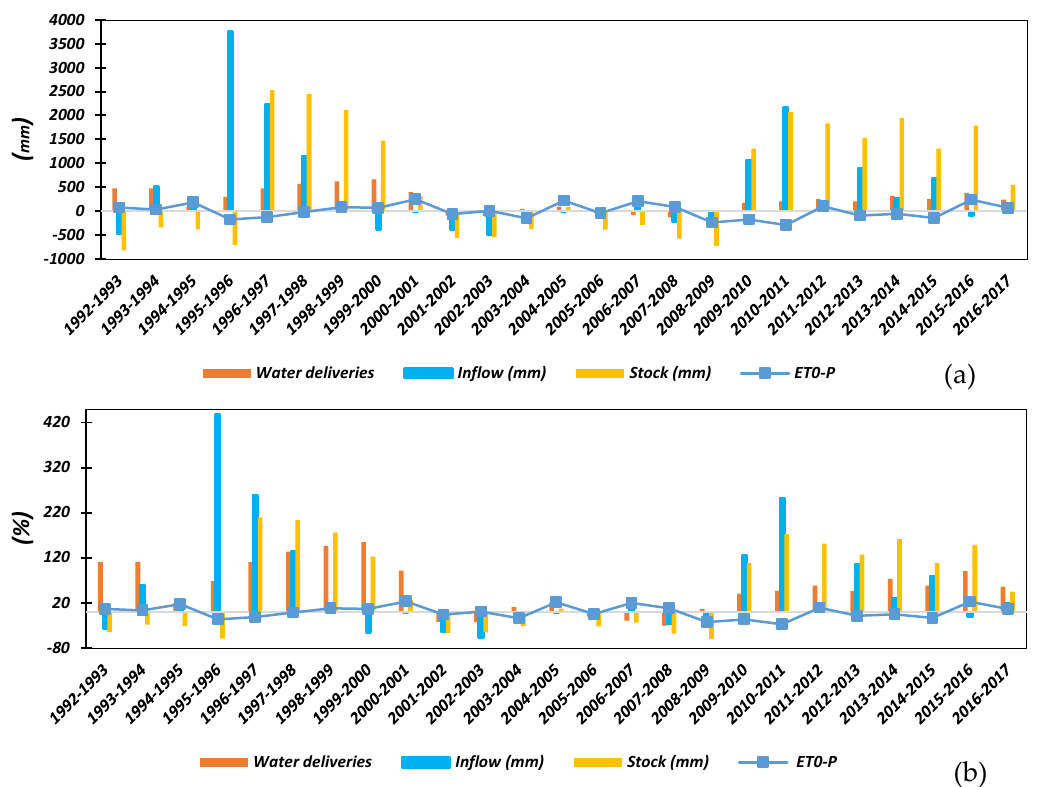
Figure 5. Anomalies (deviation of annual values from an average of ET 0 -P and W d ): ( a ) Absolute anomalies are the difference between annual values and the average over the period 1992–2017, and ( b ) relative anomalies, calculated by dividing the absolute anomalies by the average.